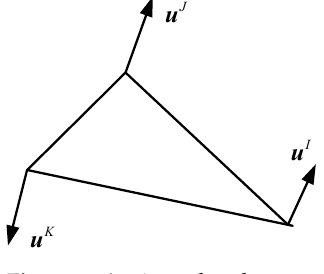
Figure 1. A triangular element.